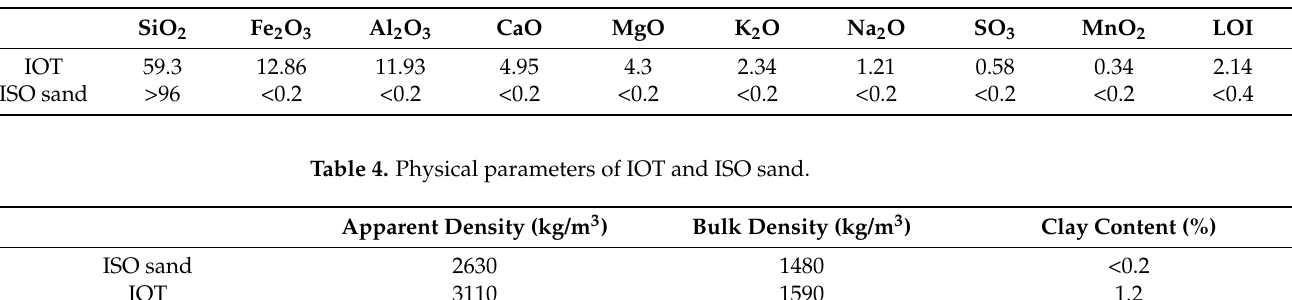
Figure 4. XRD patterns of IOT. Table 3. Chemical composition of IOT and ISO sand (unit: %).